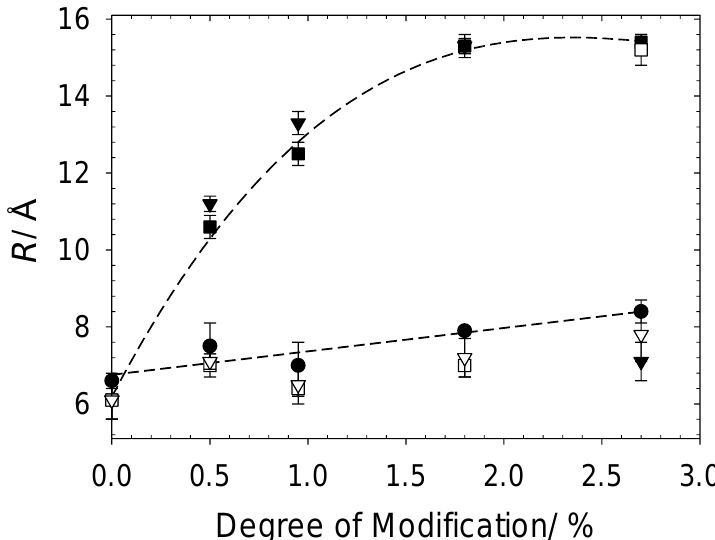
Figure 6. Fitted radius of 1 wt% cat-HEC polymers and cat-HEC/surfactant complexes (full and PE contrast). Symbols: circles, no SDS; filled squares, 2 mM h-SDS; unfilled squares, 2 mM d-SDS; filled down triangles, 4 mM h-SDS; unfilled down triangles, 4 mM d-SDS.